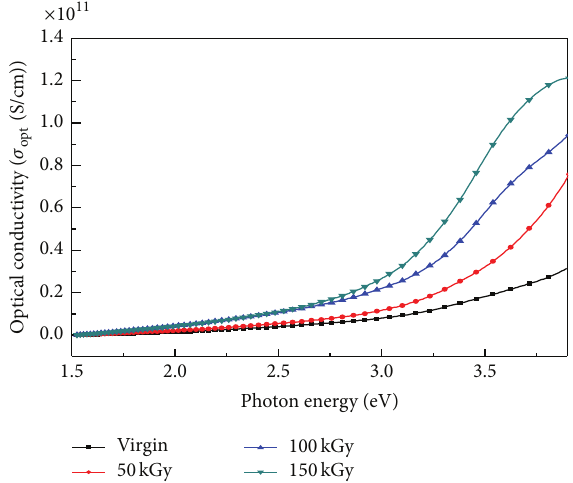
Figure 6: Variation of optical conductivity as a function of photon energy.